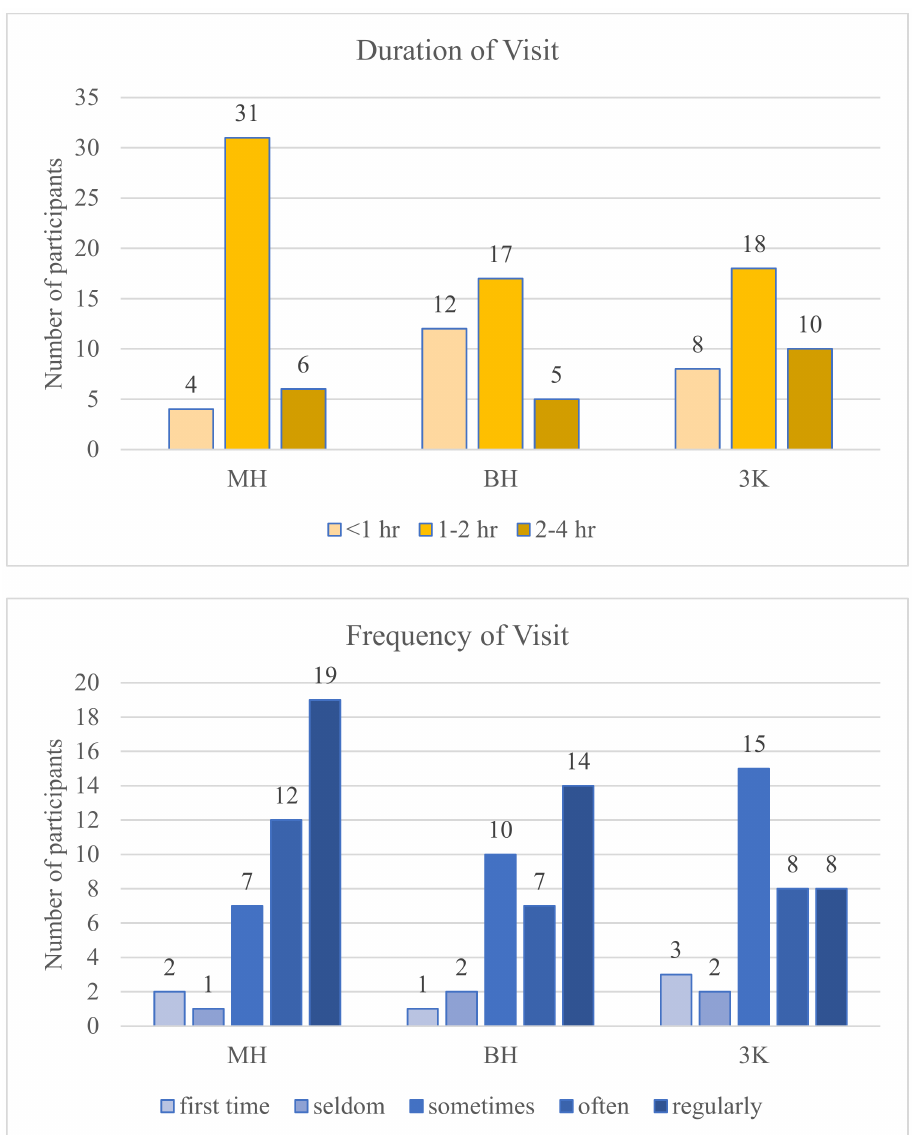
Figure 2. The frequencies of answers for distance ( top ), duration ( middle ), and frequency ( bottom ) across study locations. MH, Rai Mae Hia; BH, Buak Haad Park; 3K, Three Kings